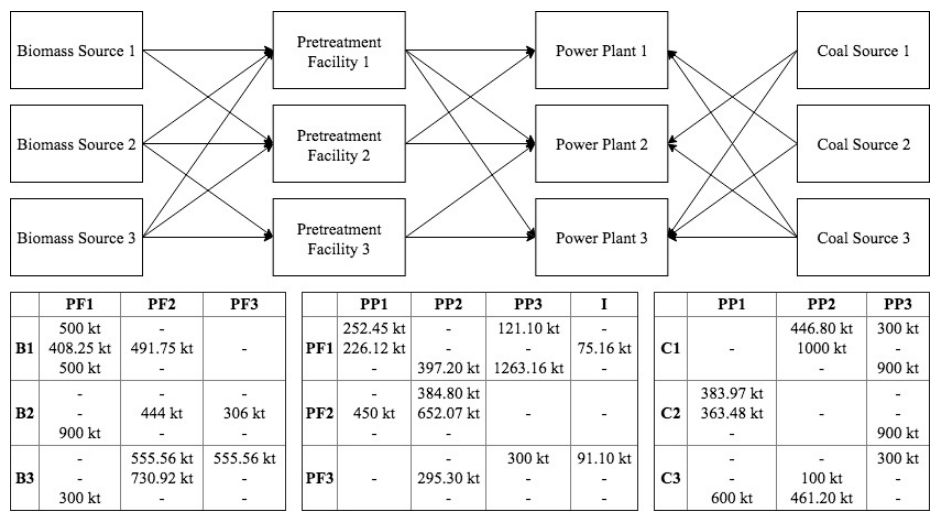
Figure 5. Minimum Environmental Emissions Network.